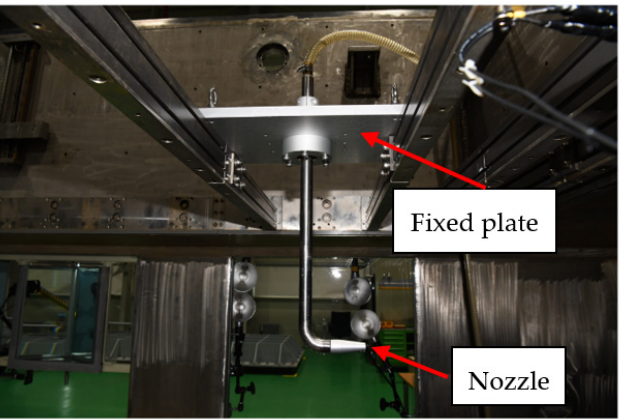
Figure 8. Device for the verification of transverse flow velocity component measured by 3-D LDV.